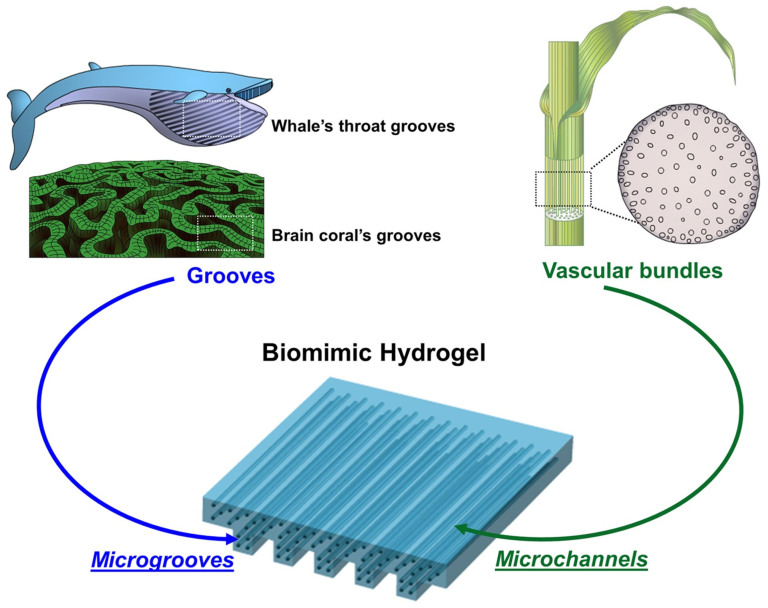
Schematic describing a strategy to control hydrogel permeability by recapitulating microgrooves of marine organisms (e.g., blue whale and brain coral) and microvascular bundles in a stem of plants.The scheme was drawn by Min Kyung Lee.